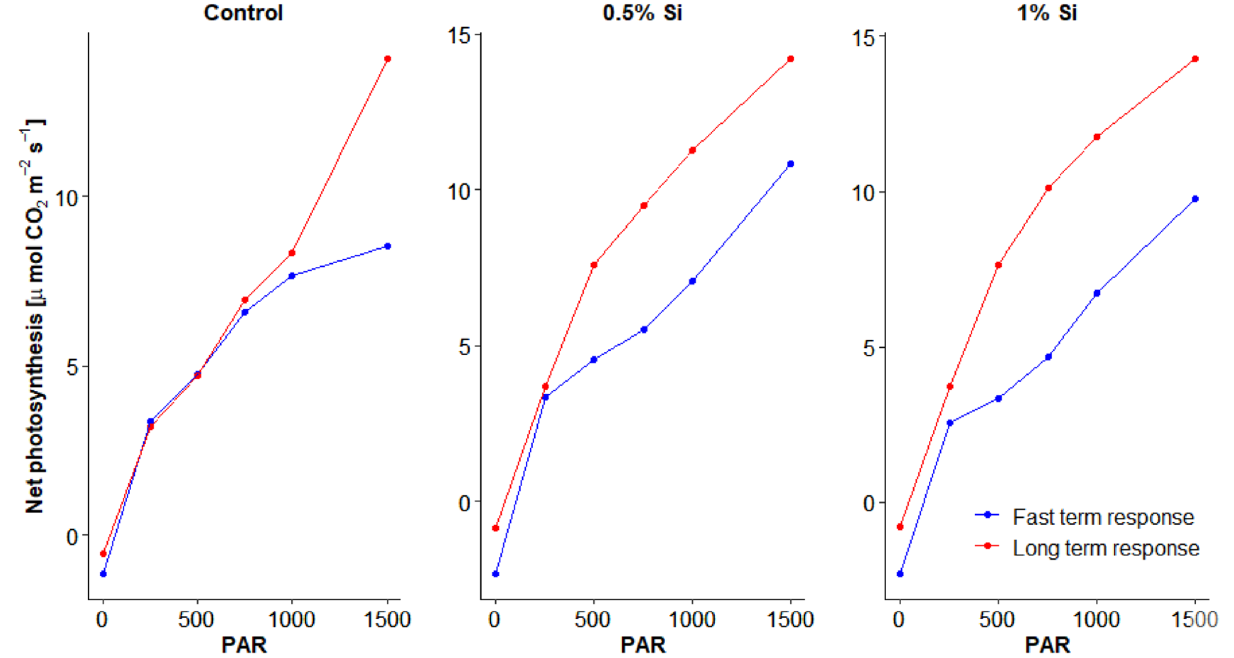
Figure 6. Fast and long term measurements of net photosythesis for the different treatments (control, 0.5% ASi and 1% ASi) at different light intensity. Data from GFS-3000 measurements at the leaf